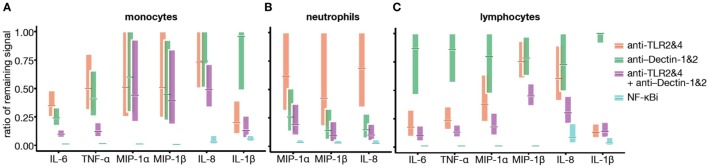
Toll-like receptor (TLR) and Dectin engagement by bacillus Calmette–Guérin (BCG) promotes NF-κB activation in an additive manner. (A–C) Data from Figures 4A–C and 5B were used to develop a mathematical model, querying whether TLR2&4 and Dectin-1&2 engagement is overlapping, additive, or synergistic in signaling via NF-κB. Cytokine concentrations were log-transformed, and ratio of remaining signal over BCG control condition was calculated for monocytes (A), neutrophils (B), and lymphocytes (C).